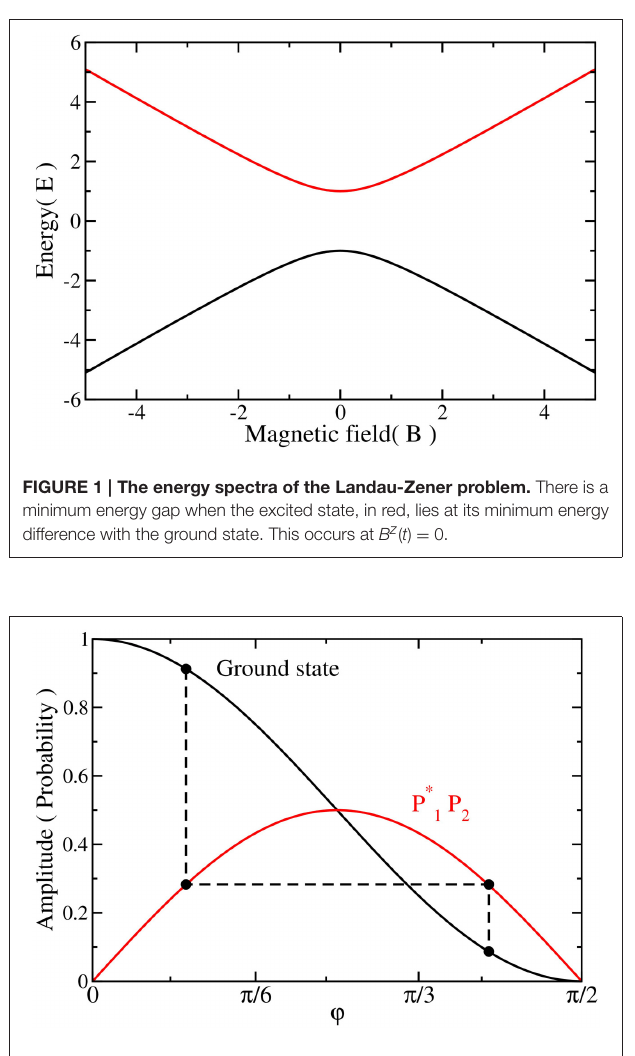
FIGURE 2 | Analytic solutions to the Landau-Zener problem showing the ground-state probability (black solid line) and the reduced amplitude of the oscillations, P * 1 P 2 , of O ( t > t stop ) (red solid line). The reduced amplitude of the oscillations is not unique to a single ground-state probability, as highlighted by the dashed line. The full oscillation amplitude is P * 1 P 2 h 1 | ˆ O | 2 i and requires knowledge of the matrix element as well.